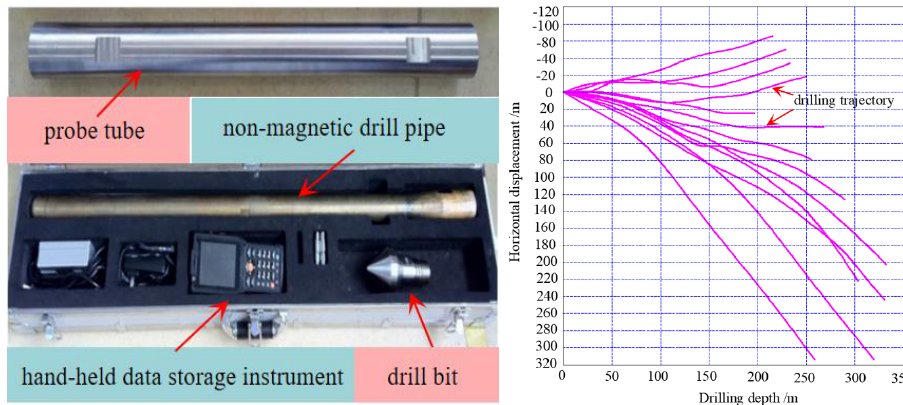
Figure 5. Drilling trajectory measurement device and measurement results.